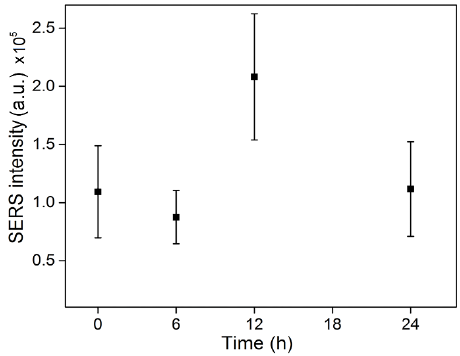
Figure 6. Mean SERS integrated intensities of the B16-F10 cells incubated with IBMX for 0, 6, 12, and 24 h. Data are expressed as the mean ± standard